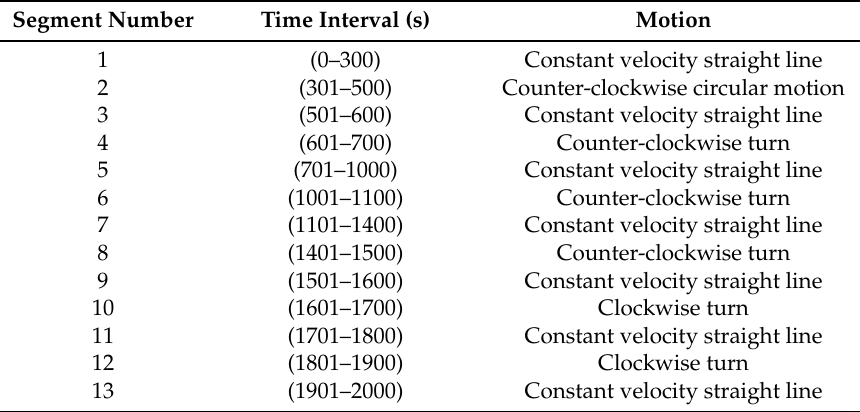
Table 3. Description of the vehicle motion for Scenario